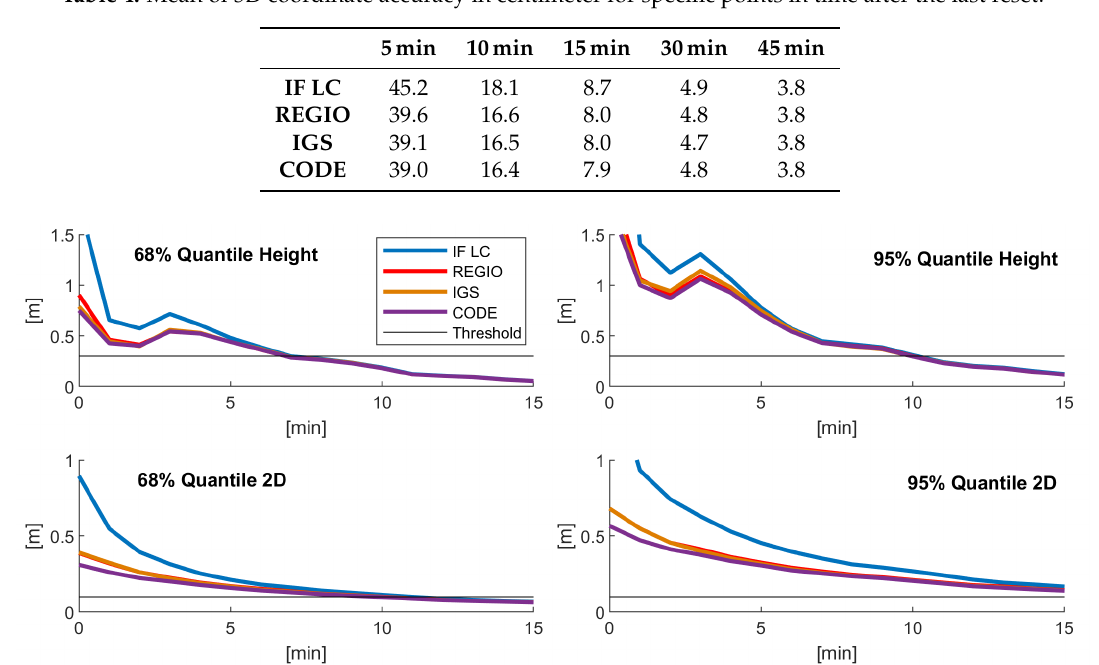
Figure 6. Percentage of converged solutions after [1, 2.5, 5, 7.5, 10, 15, 20] min for: the height component ( top ); and the horizontal position ( bottom ). The height of a bar corresponds to the percent of convergence periods which have reached convergence at this point in time. Table 4. Mean of 3D coordinate accuracy in centimeter for specific points in time after the last reset.